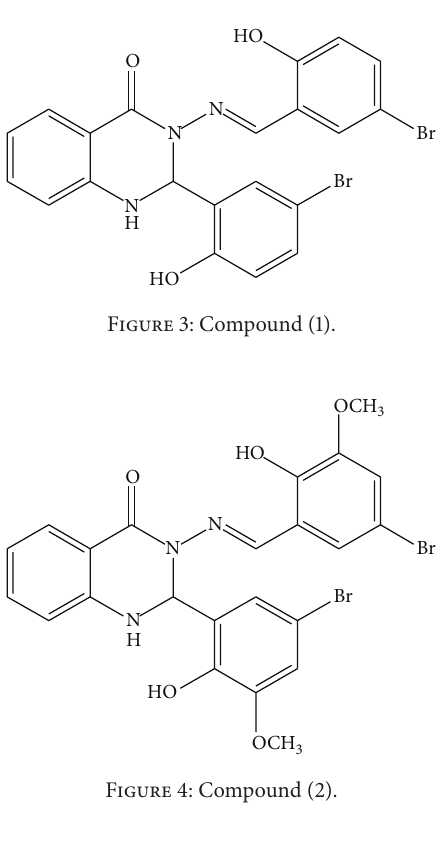
Figure 4: Compound